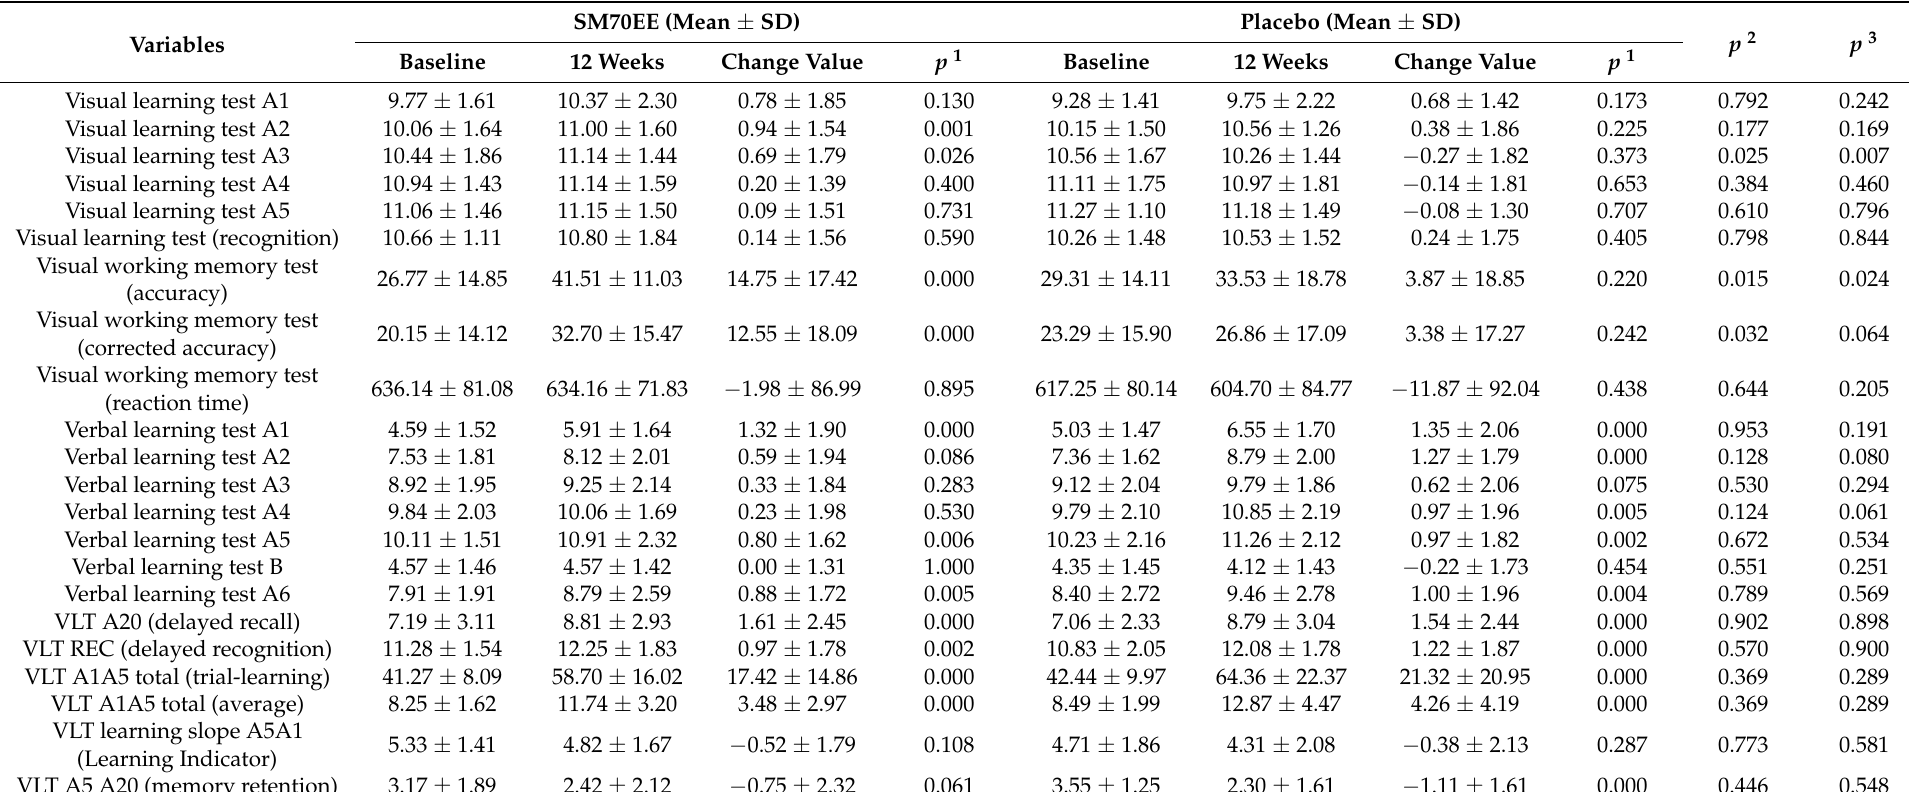
Table 3. Measurement of computerized neurocognitive test (CNT) variables at baseline and after the 12-week intervention